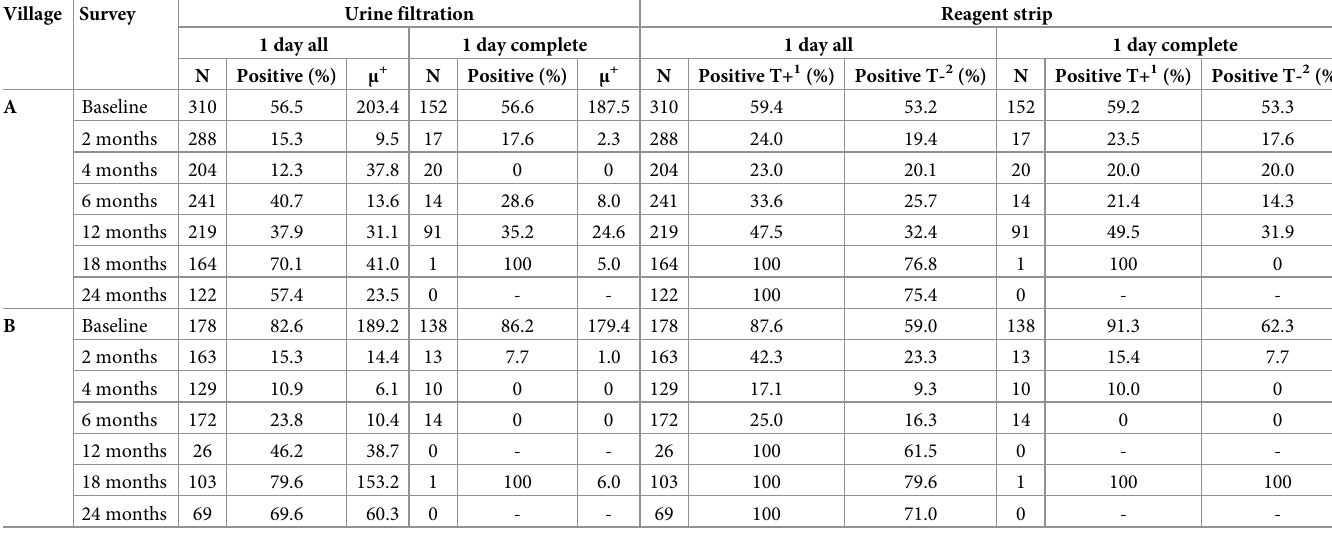
Table 1. Observed prevalence and mean infection intensity by urine filtration and prevalence by microhematuria using reagent strip based on the first sample for all individuals and based on individuals with complete data, stratified by village (Tanzania survey, 1993 [27]). Village